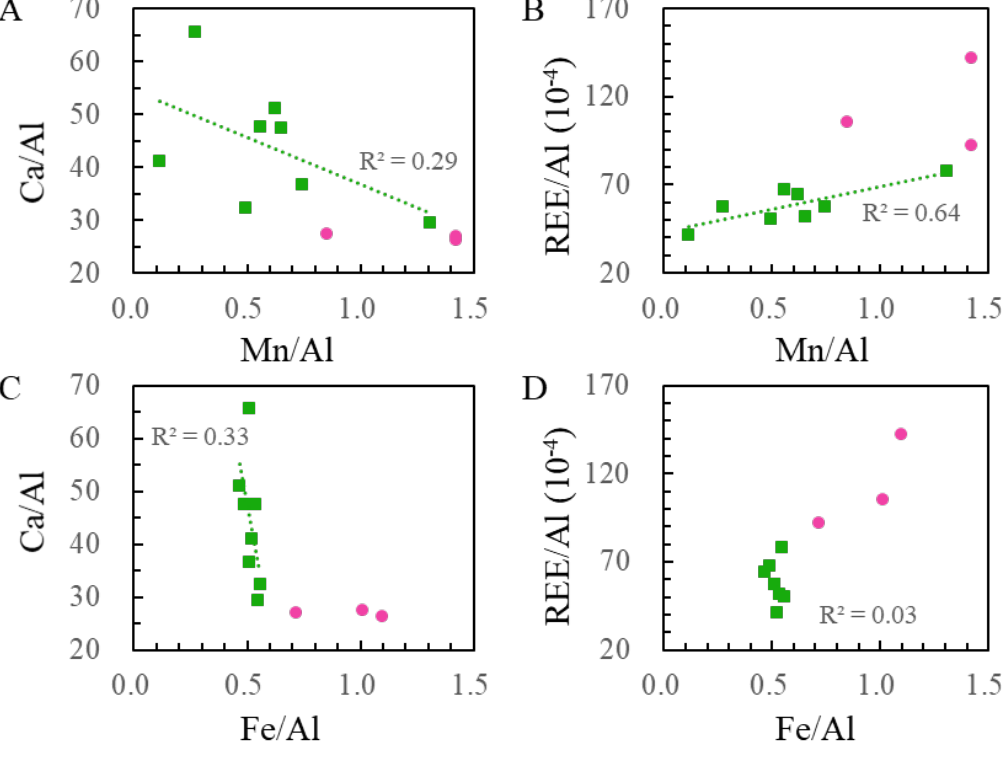
Figure 9. Plots of elemental ratios of inner carbonate (green square) and outer carbonate encrust (pink circle) with a black oxide layer. Mn / Al–Ca / Al ( A ), Mn / Al–REE / Al ( B ), Fe / Al–Ca / Al ( C ) and Fe / Al–REE / Al ( D ).